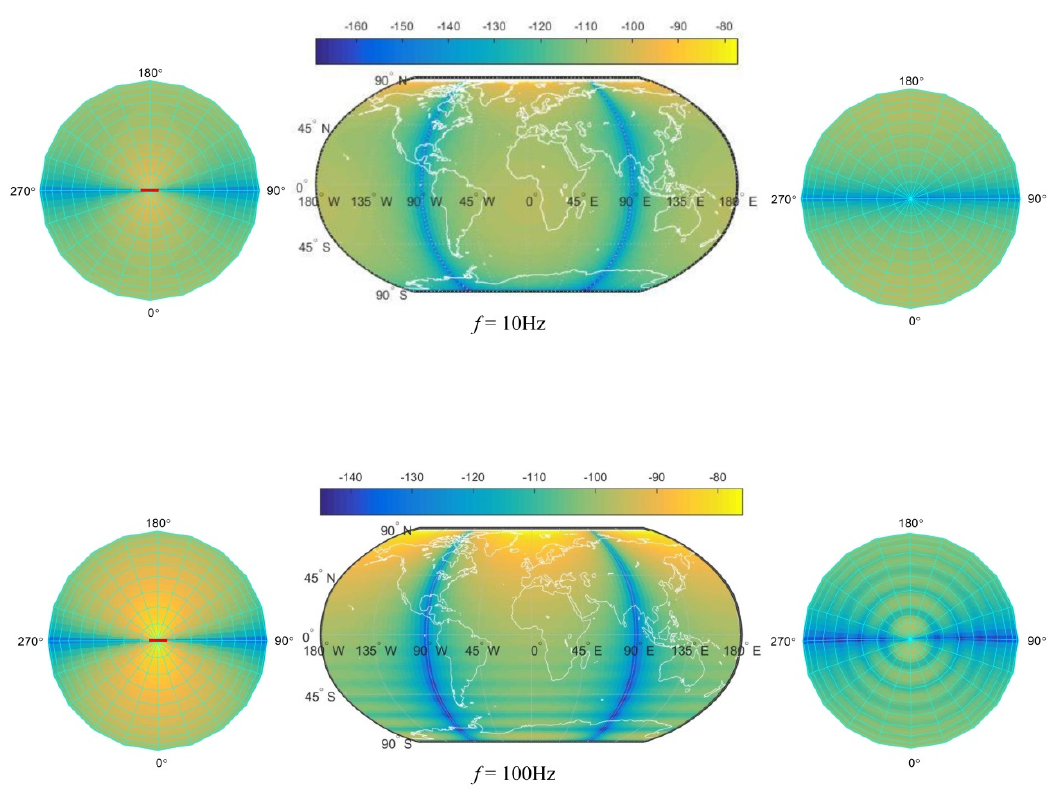
Figure 4. Spatial distribution of field component | E r | (dB) at frequencies of f = 10 Hz and f = 100 Hz. Assuming that the transmitting antenna is placed at the North Pole, the calculations are based upon the antenna length of 100 km, the transmitting current 100 A, the Earth conductivity of 10 − 3 S/m, the conductivity of the atmosphere is 10 − 14 S/m, and the resistivity of the ionosphere is 10 − 5